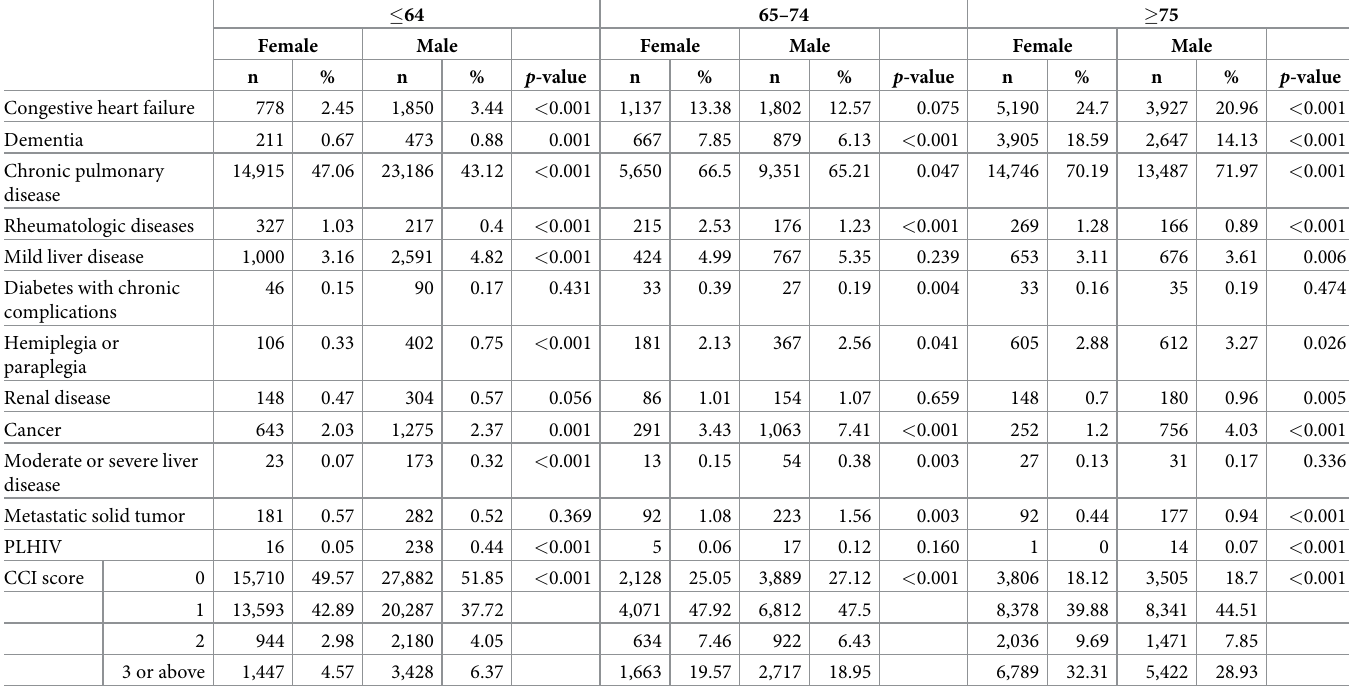
Table 3. Prevalence of various comorbidities in female and male tuberculosis patients by age